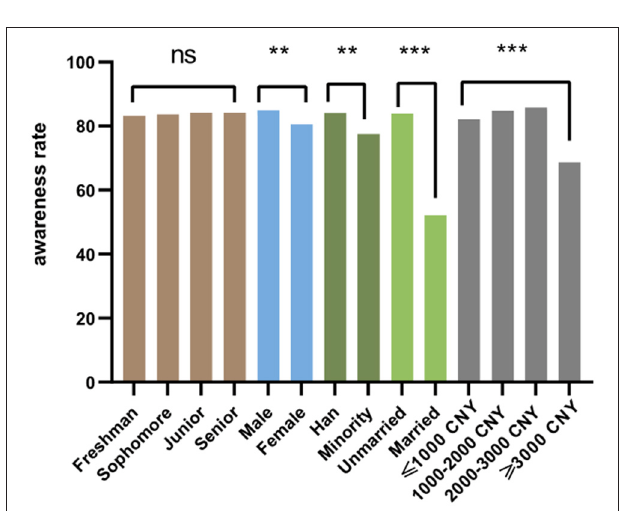
FIGURE 3 | Awareness rate of AIDS-related knowledge among college students. ns p > 0.05, * p < 0.05, ** p < 0.01, *** p <